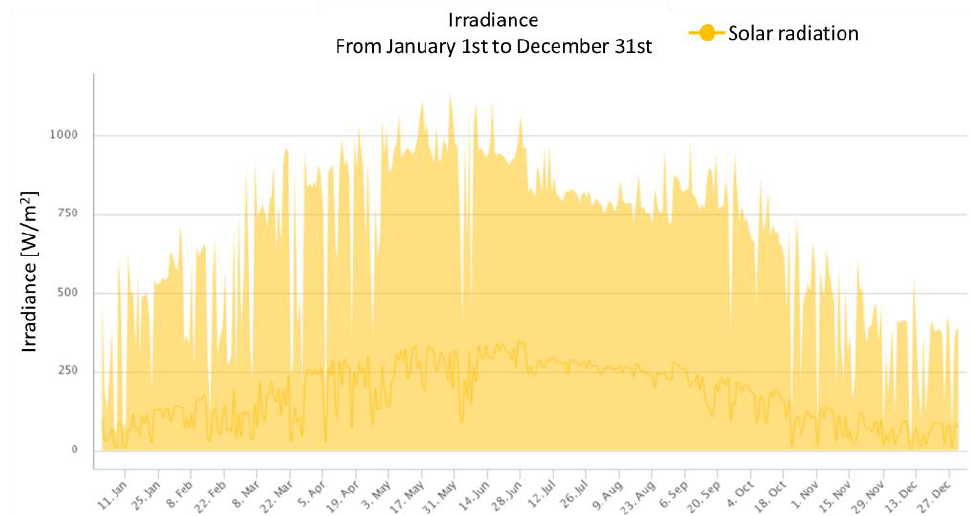
Figure 5. Annual solar radiation for the city of Portici (near Naples, Southern